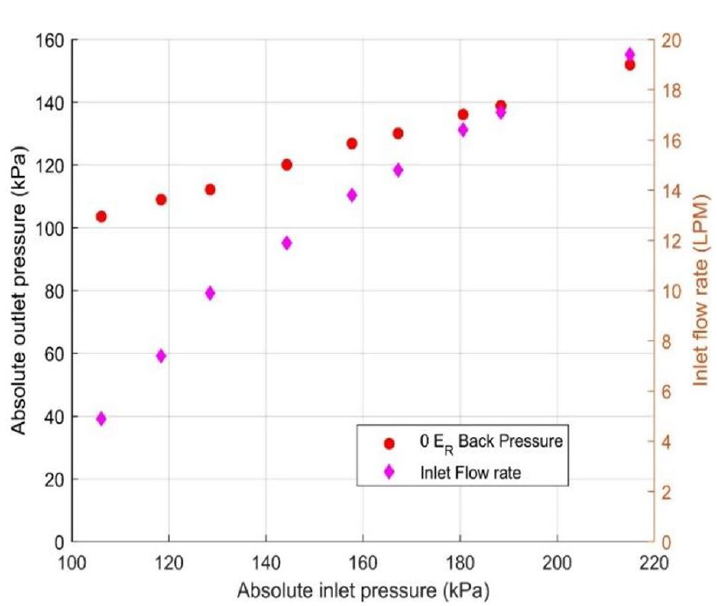
Figure 15. Optimum operational point of eductor.